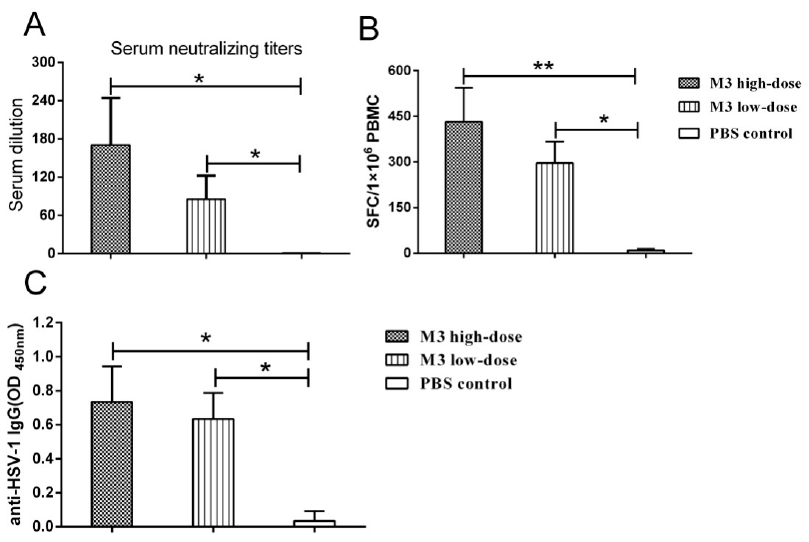
Figure 4. The immunogenicity of the M3-immunized macaques. ( A ) The neutralizing antibody testing of the serum from the high-dose, low-dose, and PBS control groups. ( B ) ELISpot detection of IFN- γ for the analysis of specific T cell responses in the high-dose, low-dose, and PBS control groups. ( C ) ELISA detection of IgG antibodies in serum from the high-dose, low-dose, and PBS control groups. (* indicates p < 0.05; ** indicates p < 0.01).